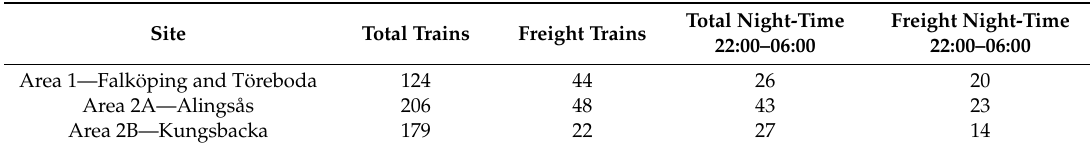
Table 1. Daily train passages at the study